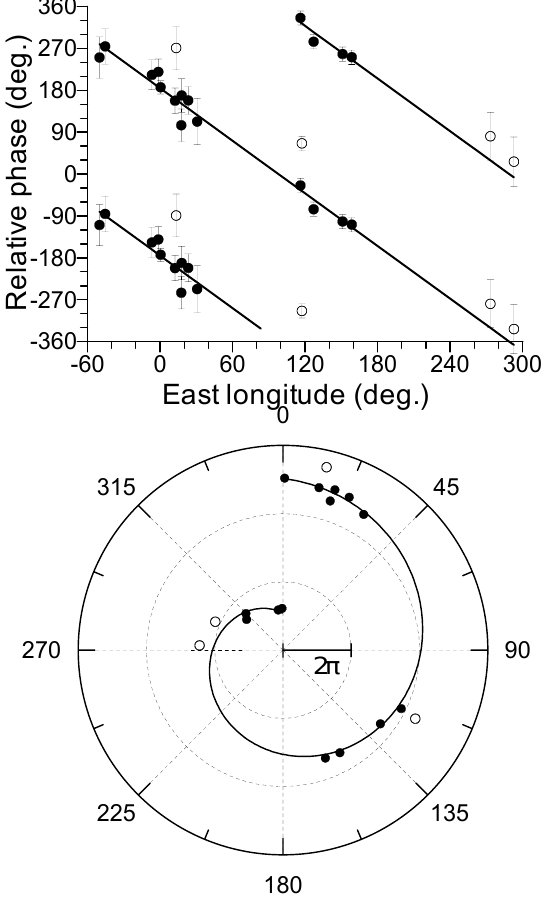
Fig. 8. The plot at the top depicts the phases of the 6-day oscillation in the fo F2 as a function of the longitude (open and full circles). The straight lines in the top plot mean the best linear fit. The polar plot at the bottom depicts the phase (radius) as a function of the longitude (angle), where the line means the assumed phase function ϕ(λ) for a westward propagating wave with s = 2 and the dots (open circles) represent the measured phases by taking into account that a new cycle of oscillation starts within a longitude sector. See text for details.